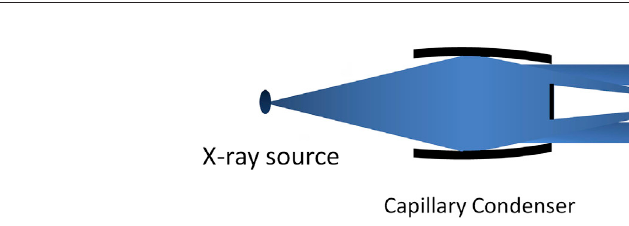
FIGURE 1 | Schematic diagram of the TXM system based on the capillary condenser.